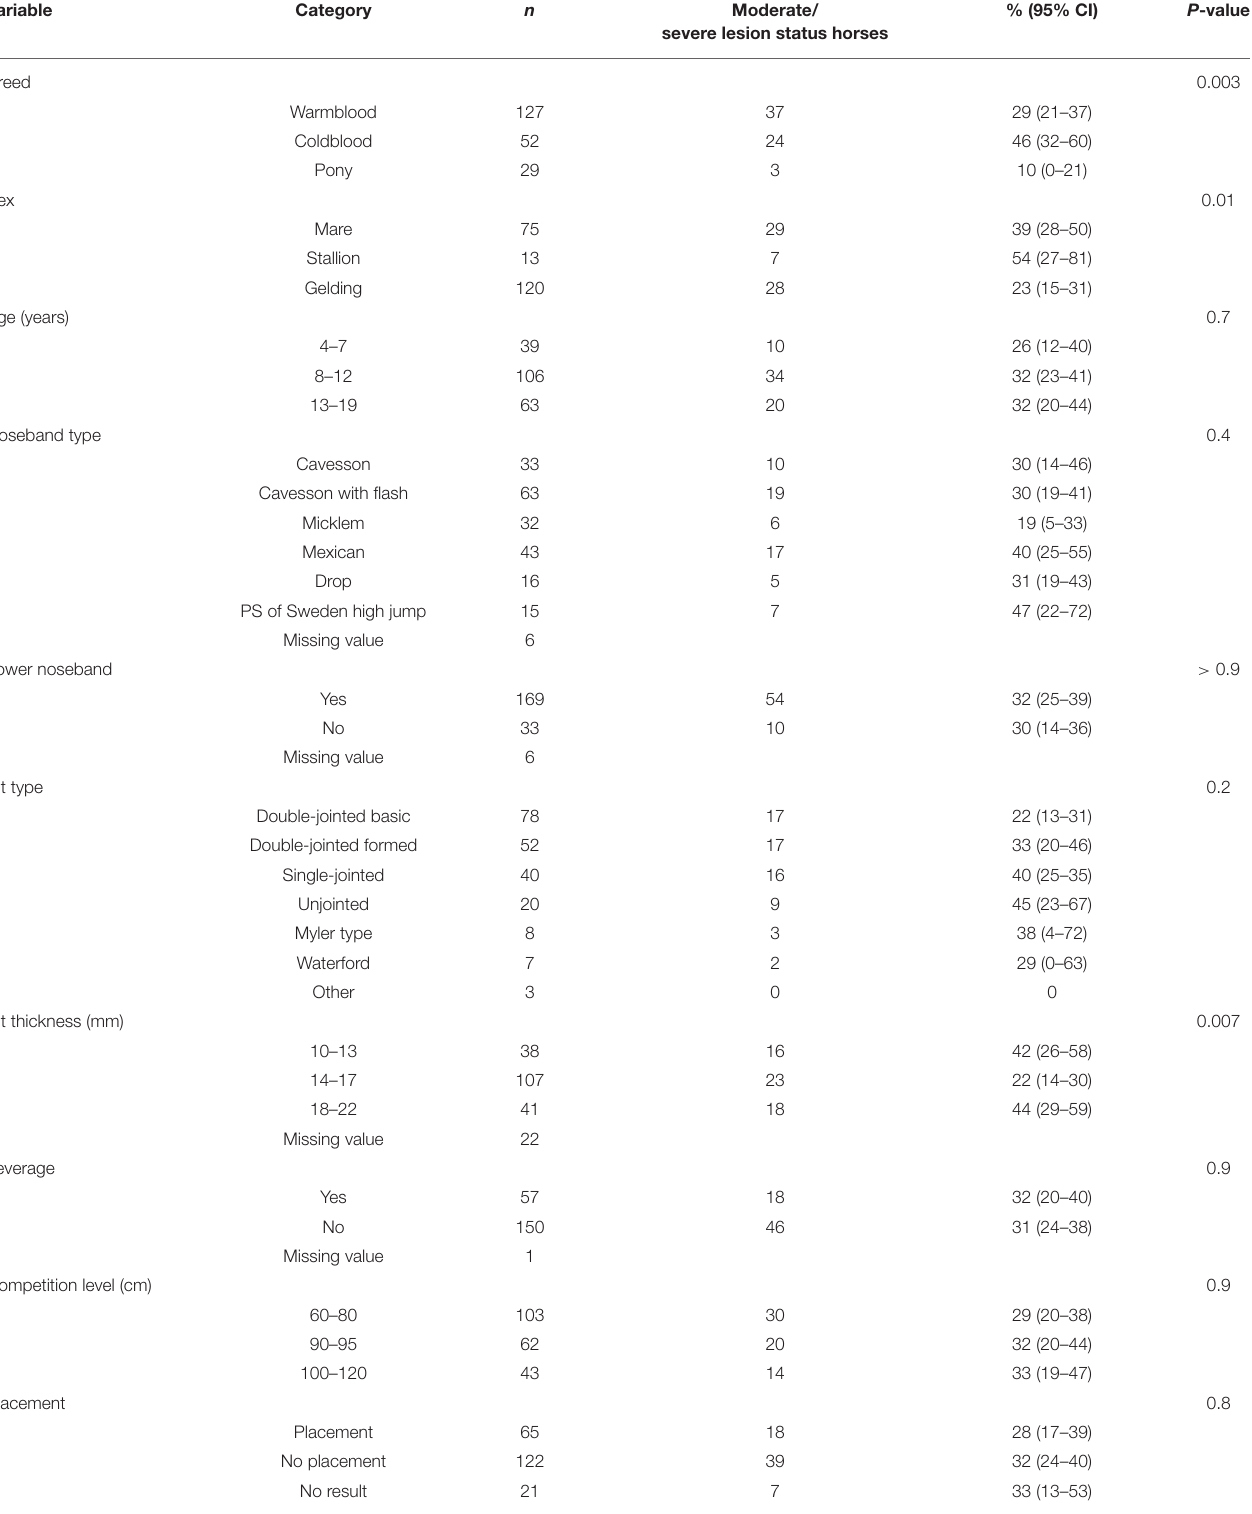
TABLE 1 | Event horses ( N = 208) and their risk factors for moderate or severe oral lesion